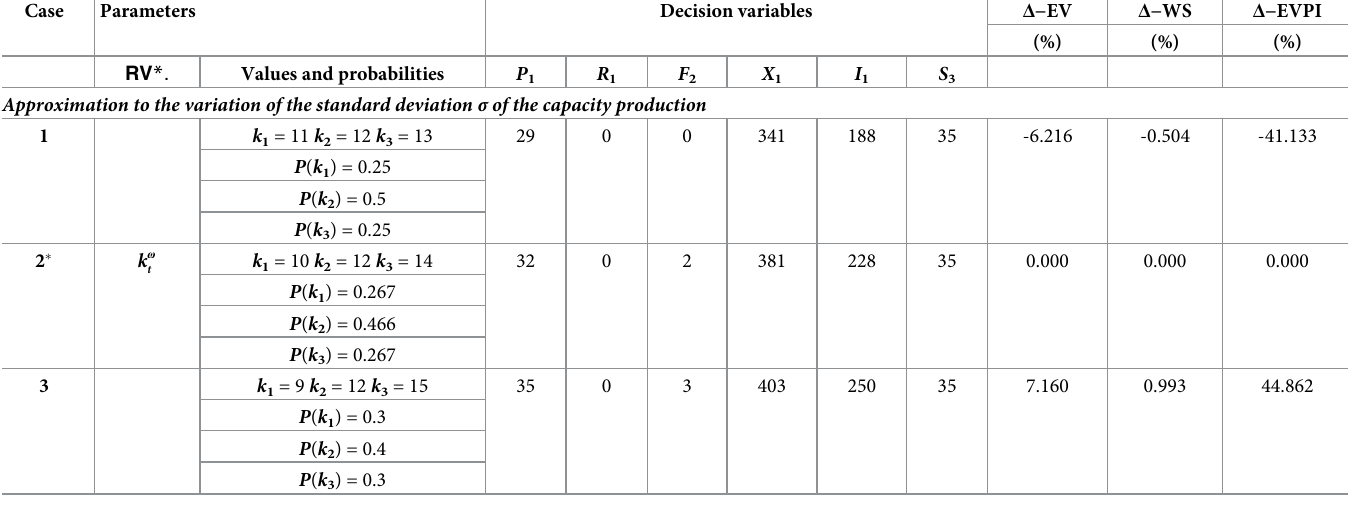
Table 15. Model-II sensitivity analysis varying parameters of the probability distribution. Own elaboration, " � " denotes the base case. Case RV * . Approximation to the variation of the standard deviation σ of the capacity